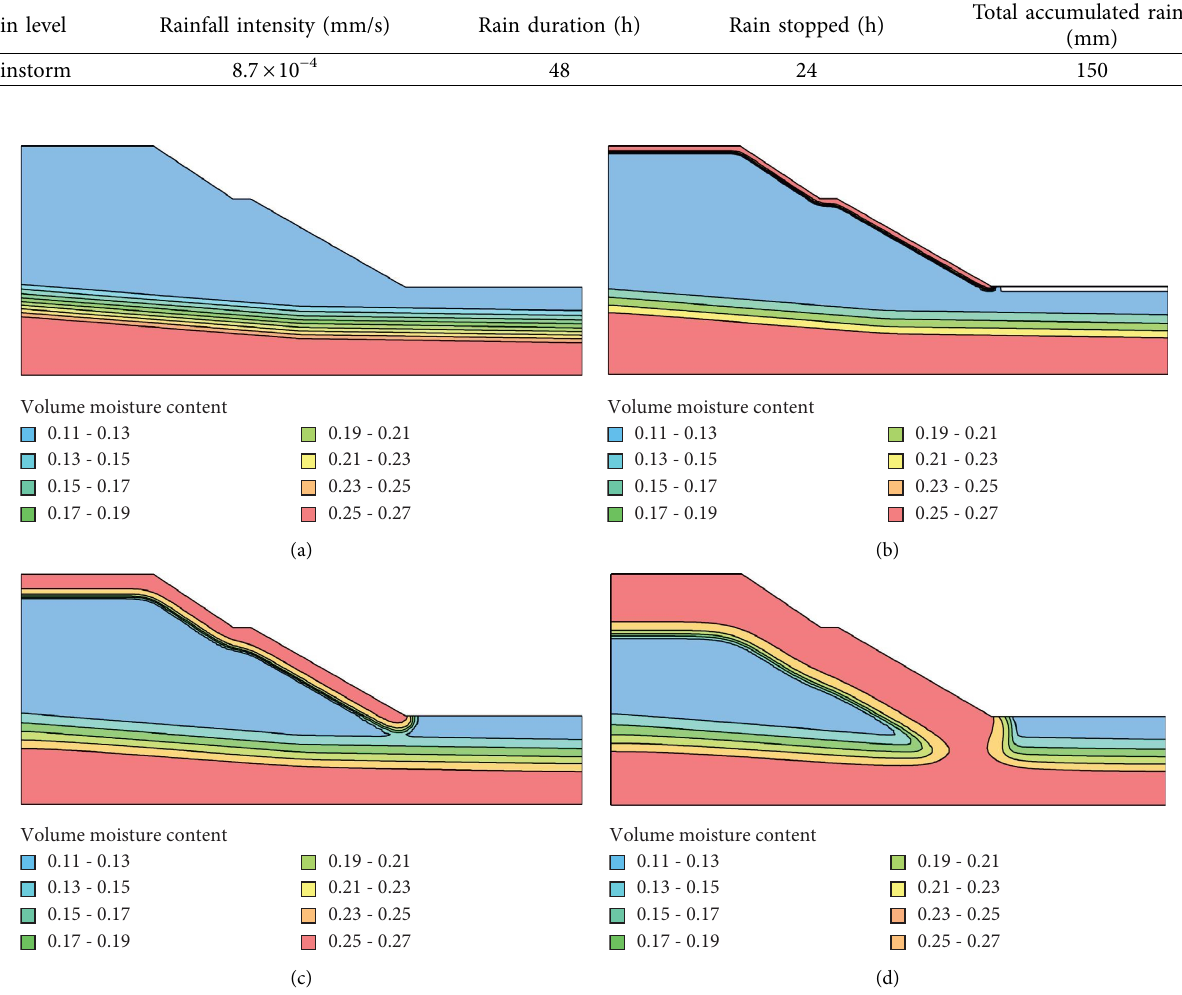
Figure 5: Slope volumetric water content distribution law. (a) Slope initial state. (b) Rain lasted 6 hours. (c) Rain lasted 24hours. (d) Rain lasted 48hours.